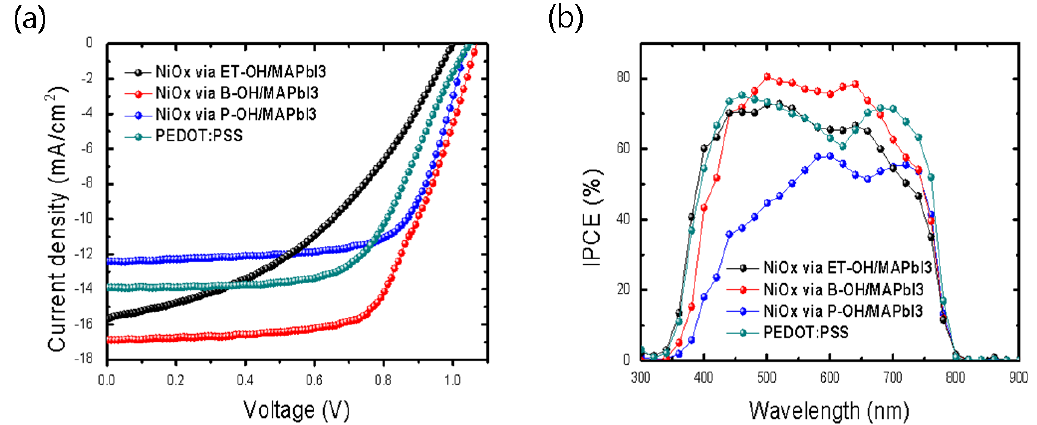
Figure 2. ( a ) J-V characteristics of inverted PSCs (Perovskite Solar Cells) using sol-gel-based NiO x transport layers synthesized via three solvents and using PEDOTP:PSS (poly (3,4 ethylenedioxythiophene):polystyrene sulfonate); AM 1.5G, 100 mW/cm 2 under solar simulaton.